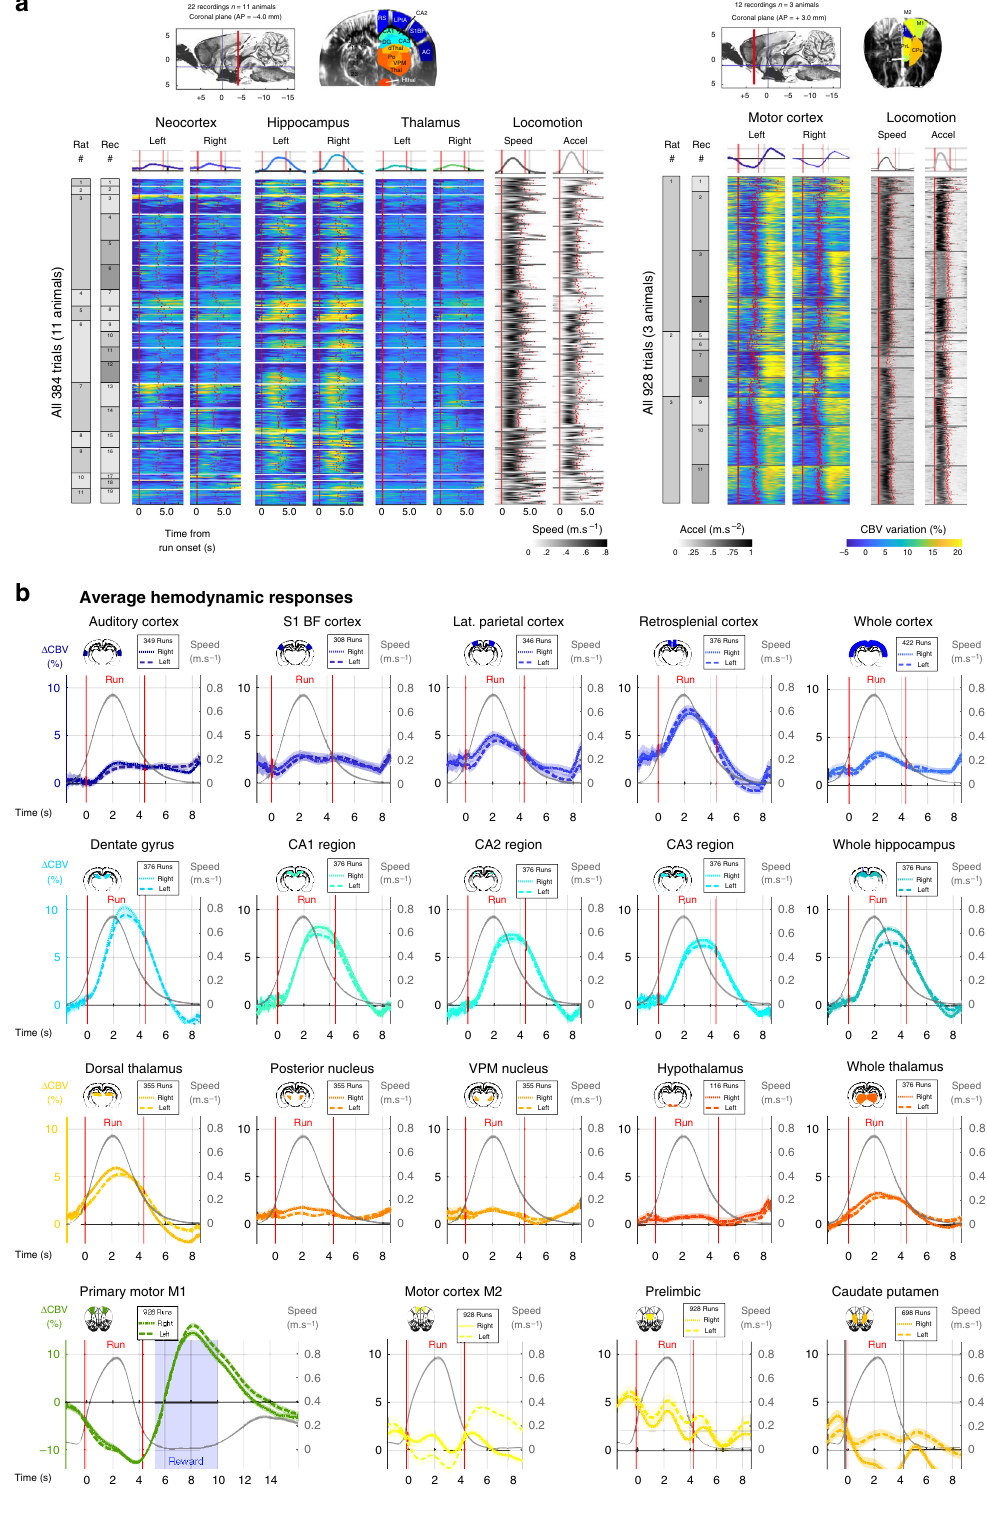
dorsal thalamus (0.93 s ± 0.15 s), then reaching dentate gyrus (1.15 s ± 0.06 s) and fi nally CA3 (1.22 s ± 0.08 s) and CA1 regions (1.38 s ± 0.08 s). This time, only the delay between dentate gyrus and dorsal thalamus was found signi fi cant (Wilcoxon signed-rank test, P < 0.05) as well as the delay between DG and CA1 ( P